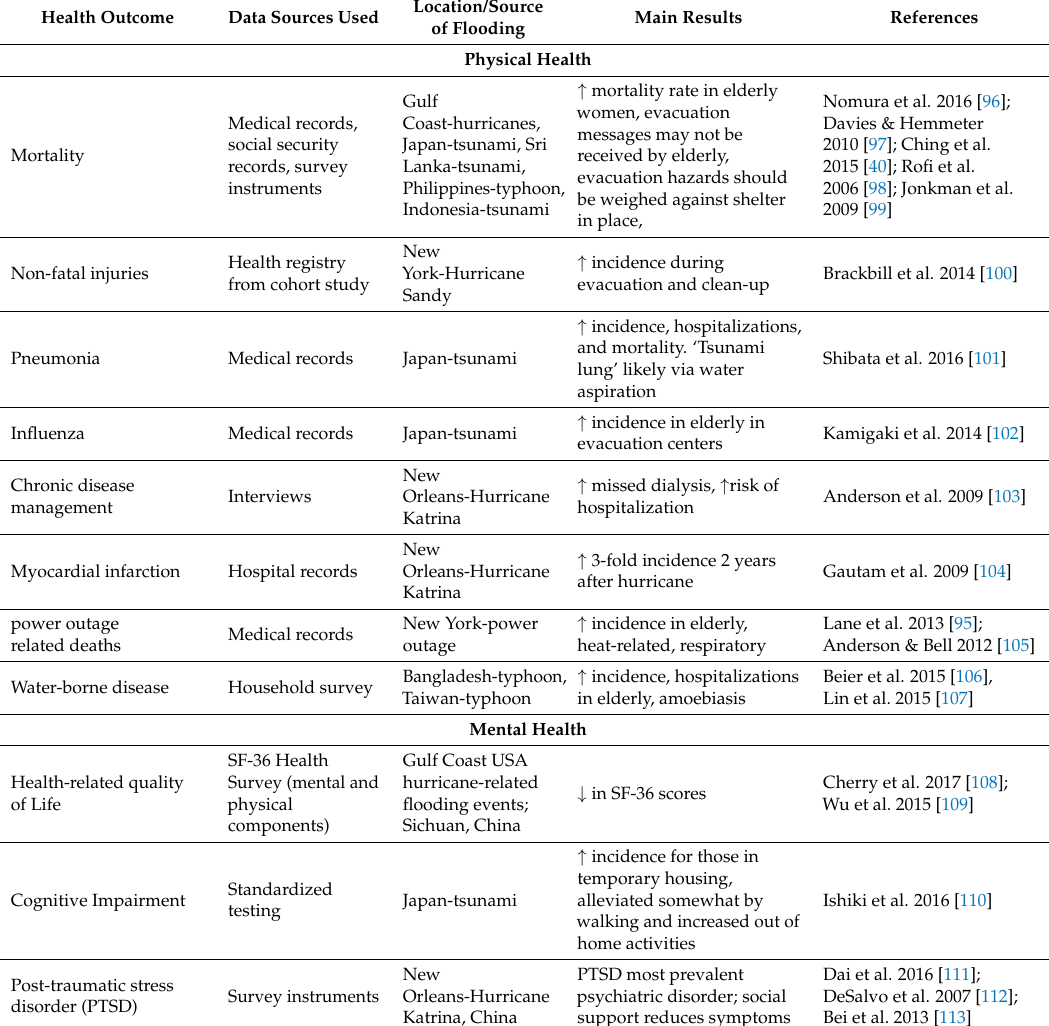
Table 5. Health outcomes associated with coastal flooding in older